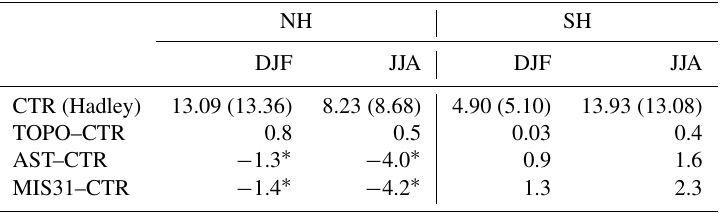
Table 1. Sea ice area (10 9 m 2 ) in the NH and SH for the Hadley Centre Sea Ice (in brackets), CTR, and differences between the sensitivity experiments and CTR. Values with asterisks are statistically significant at 95% based on t -test